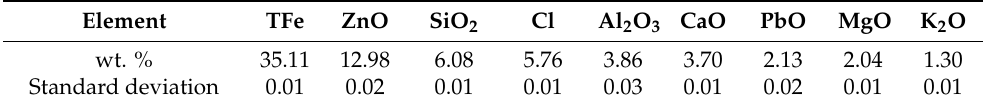
Table 1. Chemical multielement analysis of zinc-bearing dust sludge (wt.%). Element TFe Standard